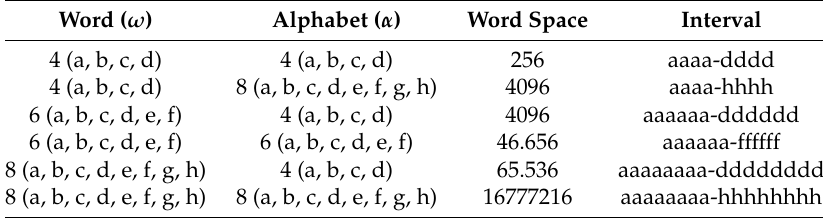
Table 8. Variation of word size and alphabet size